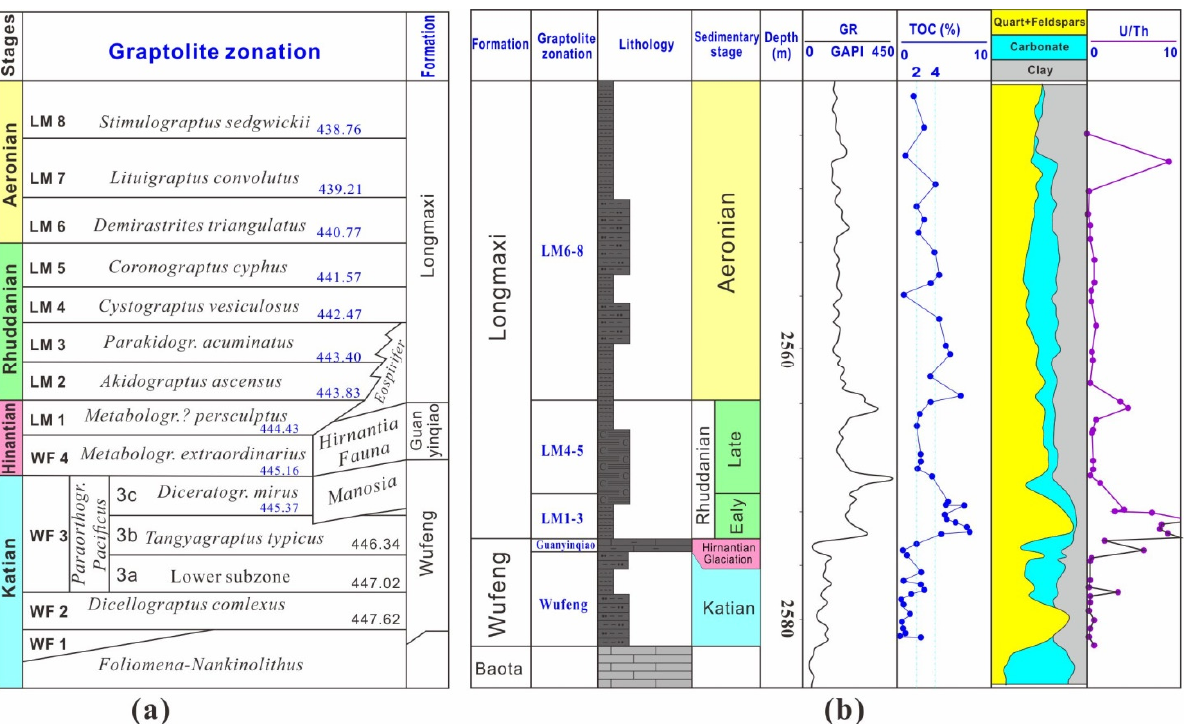
Figure 1. ( a ) Subdivision of the Wufeng–Longmaxi formations into units based on graptolite zona- tion: (Katian, Hinantian, Rhuddanian, and Aeronian: WF1-4 and LM1-8) [40]; ( b ) Typical stratigraphic column for the Wufeng–Longmaxi formations and its subdivisions in the Weiyuan location used in this study [41].